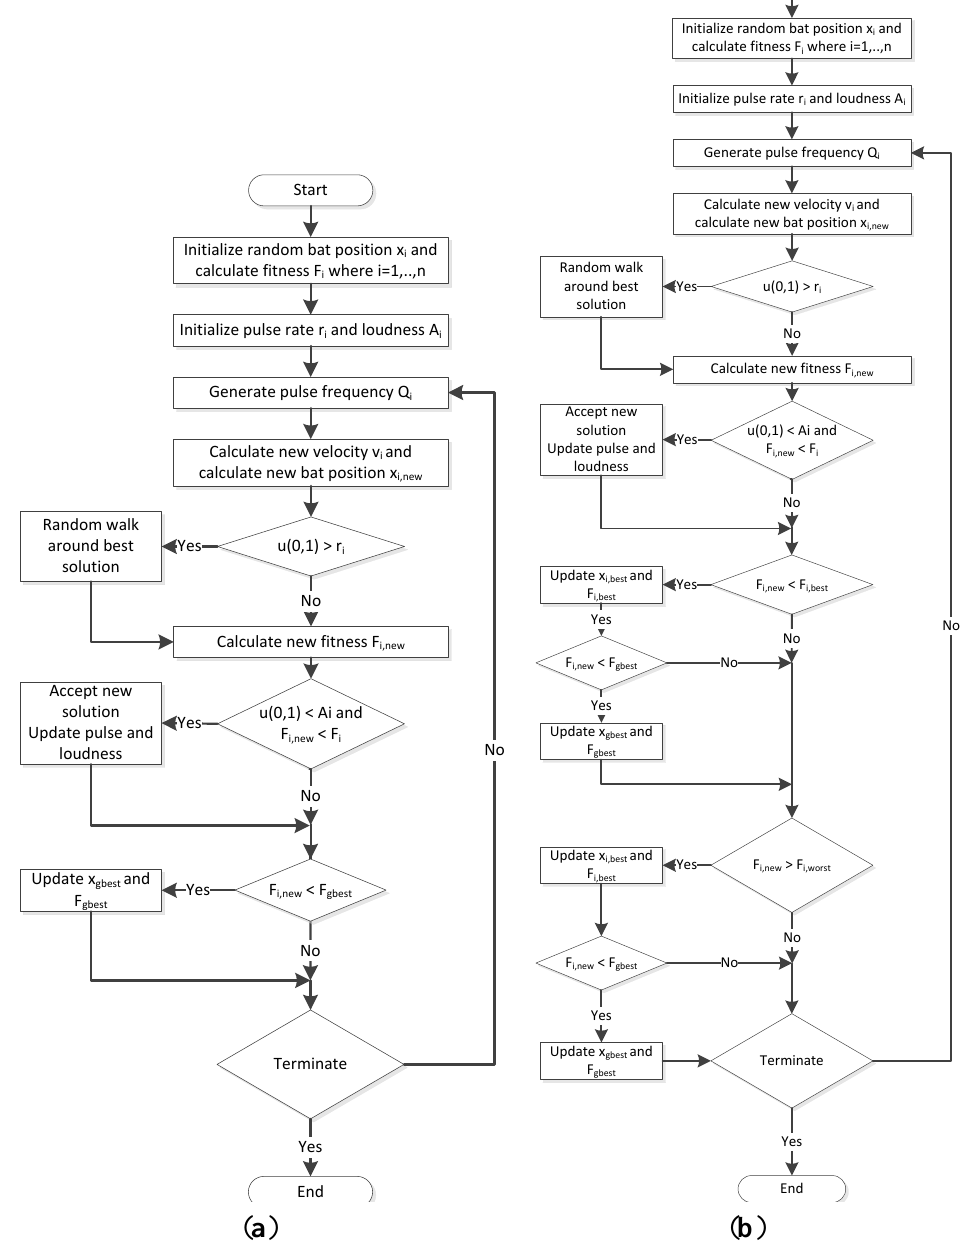
Figure 2. ( a ) Bat Algorithm ( b ); Modified Bat